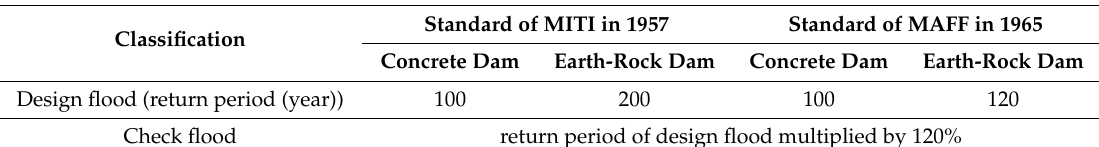
Table 8. Flood control standard for reservoir engineering in Japan. MITI, Ministry of International Trade and Industry; MAFF, Minister of Agriculture, Fisheries and